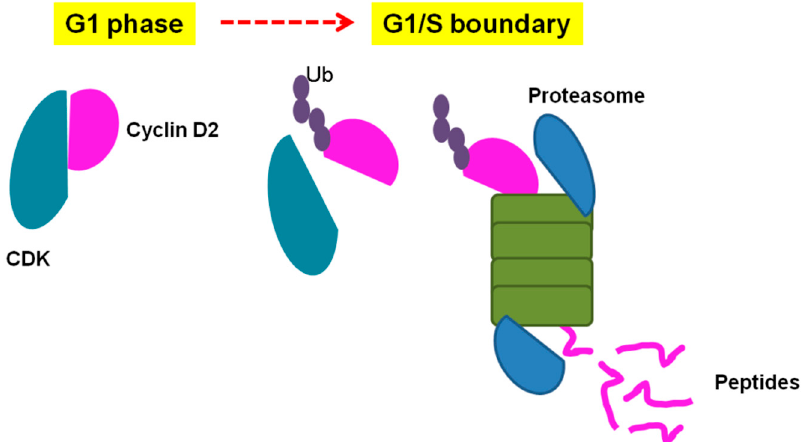
Figure 2. Hypothetical model of Pep5 generation by the ubiquitin–proteasome system (UPS). During G1 phase, cyclin D2 forms a complex with cyclin-dependent kinases (CDKs) to regulate several processes. At the G1 / S boundary, the cyclin D2 levels decrease after ubiquitination (Ub) and proteasome degradation. As a result of this degradation, several peptides are formed and released in the intracellular environment. Some of the peptides will be entirely degraded by peptidases whereas some peptides (e.g., Pep5) will remain in the cells to participate in biological processes.